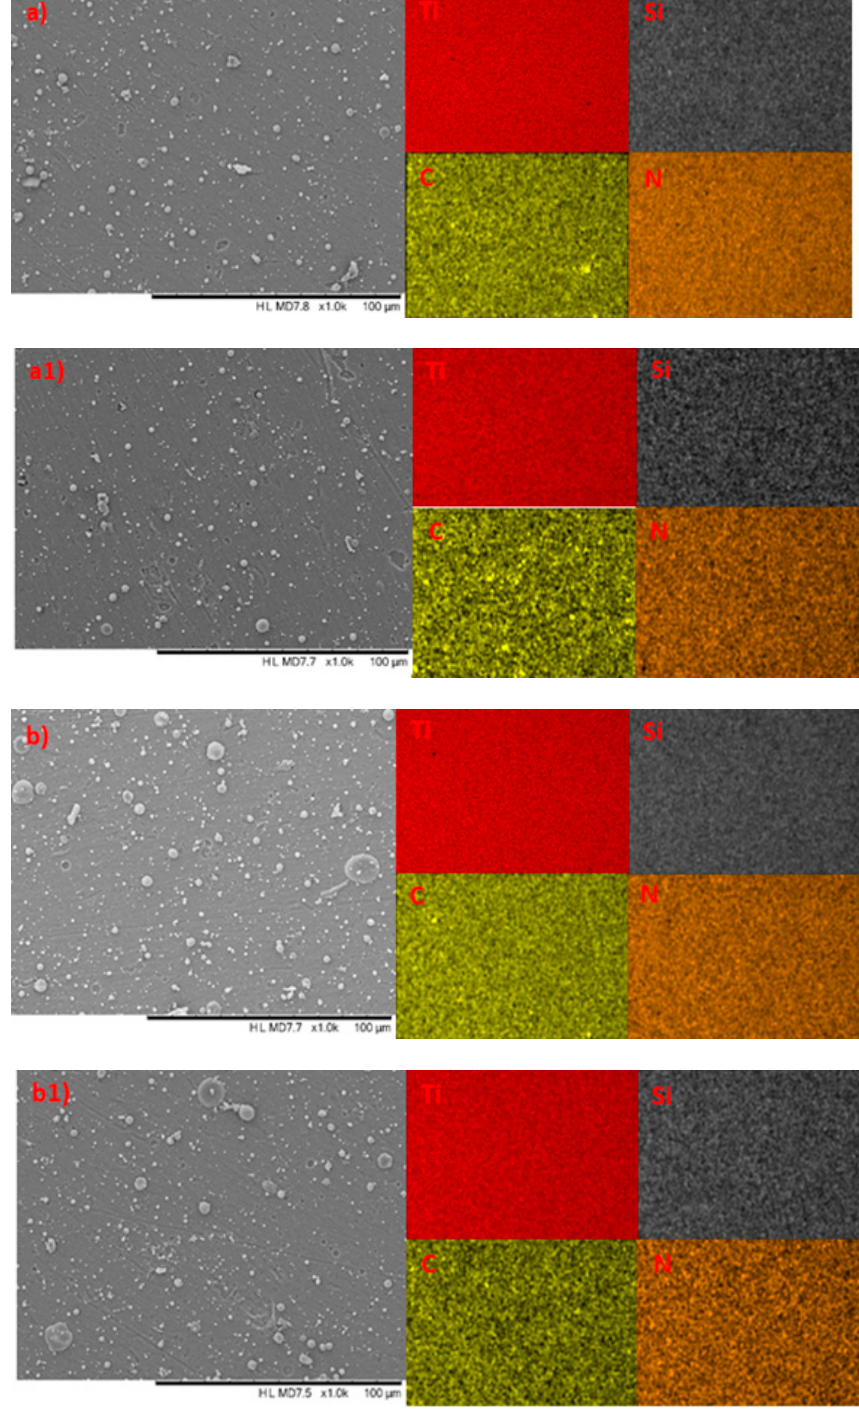
Figure 3. SEM images of TiSiCN coatings on Ti6Al4V alloy with elemental mapping profiles: ( a ) TiSiCN-1 before corrosion testing; ( a1 ) TiSiCN-1 after corrosion; ( b ) TiSiCN-2 before corrosion testing; and ( b1 ) TiSiCN-2 after corrosion.